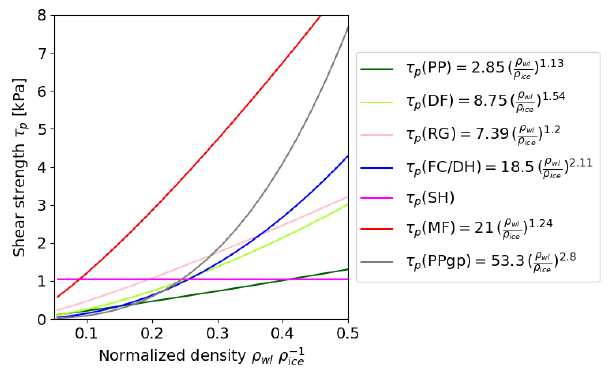
Figure 2. Parameterization of the shear strength τ p as implemented in SNOWPACK. Except for surface hoar (SH), τ p is a power-law (cid:1) b . Values for a and b function of normalized density τ p = a (cid:0) ρ wl ρ ice depend on grain type. Grain types are precipitation particles (PP), decomposed and fragmented precipitation particles (DF), rounded grains (RG), faceted crystals (FC), depth hoar (DH), surface hoar (SH), melt forms (MF), and graupel